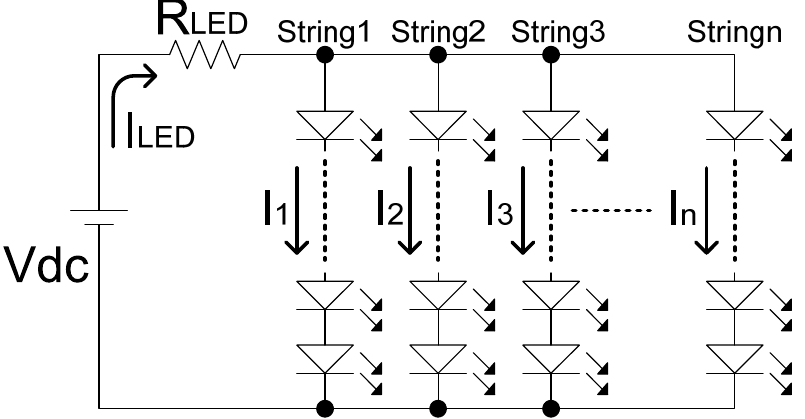
Figure 1. Simplified LED driving circuit with multi-string